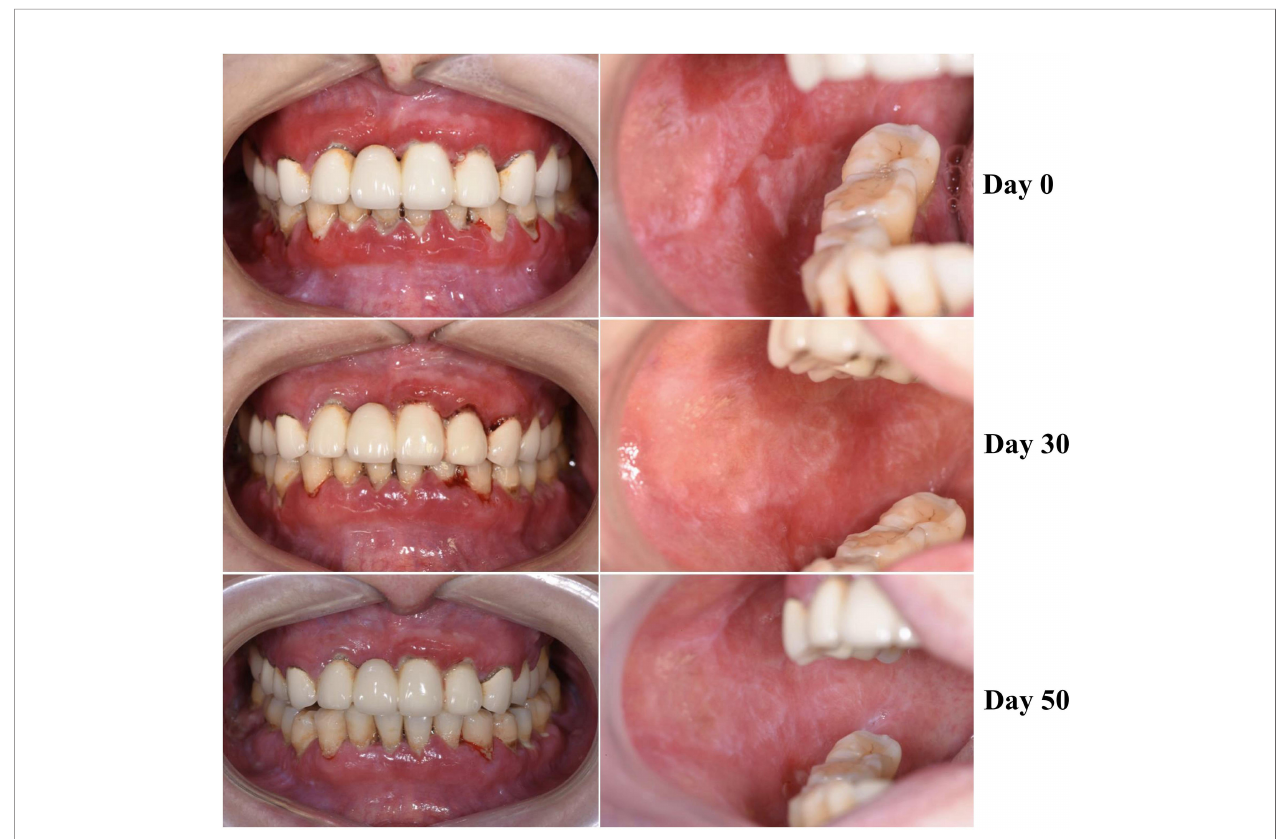
FIGURE 1 | Changes of clinical features of this patient. The clinical features on the gingivae (left) and buccal mucosa (right) at Days 0, 30 and 50 are